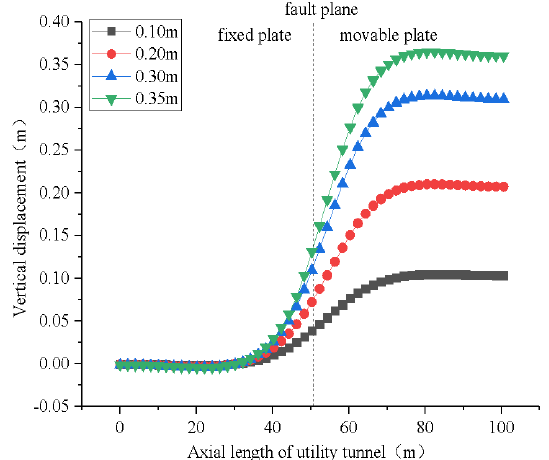
Figure 6. Vertical displacement distribution curve.